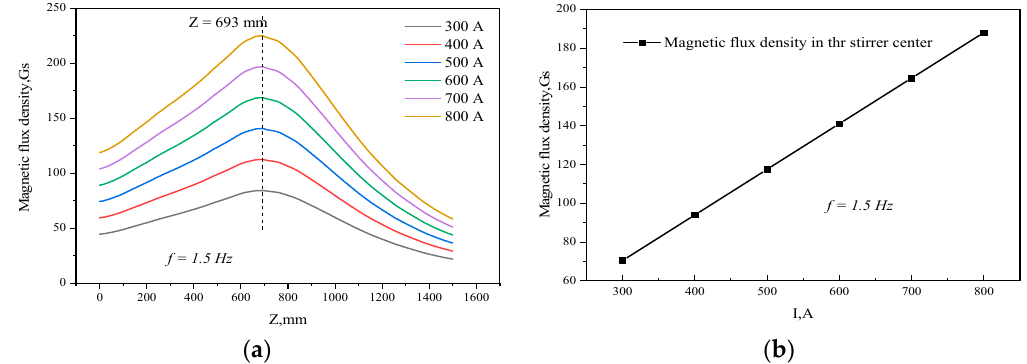
Figure 4. Distribution of magnetic flux density under different current intensities: ( a ) along the strand central axis; ( b ) in the stirrer center.